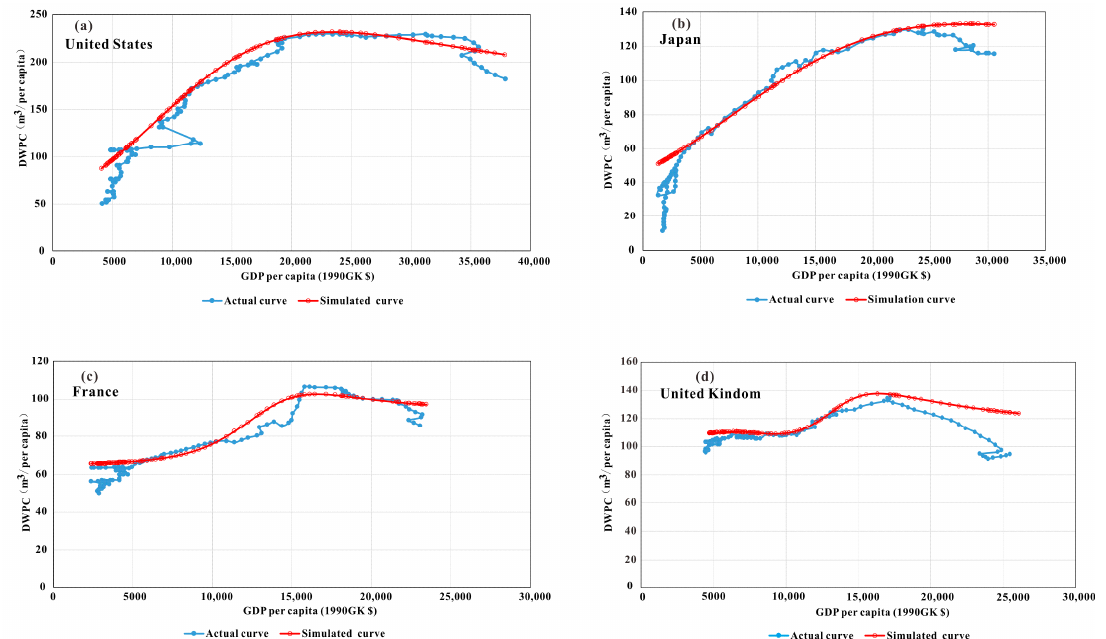
Figure 4. Expanded S-curve simulation of DWPC and GDP for ( a ) the United States ( b ) Japan, ( c ) France, and ( d ) the United Kingdom.